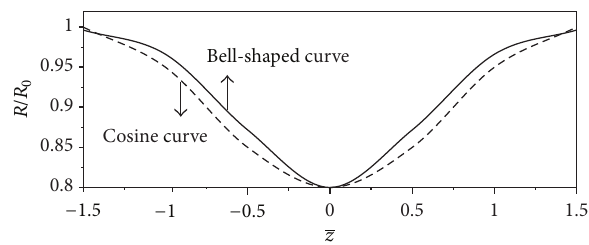
Figure 10: Variations of skin friction 𝜏 2 with axial distance for different values of yield stress 𝜏 𝐶 .